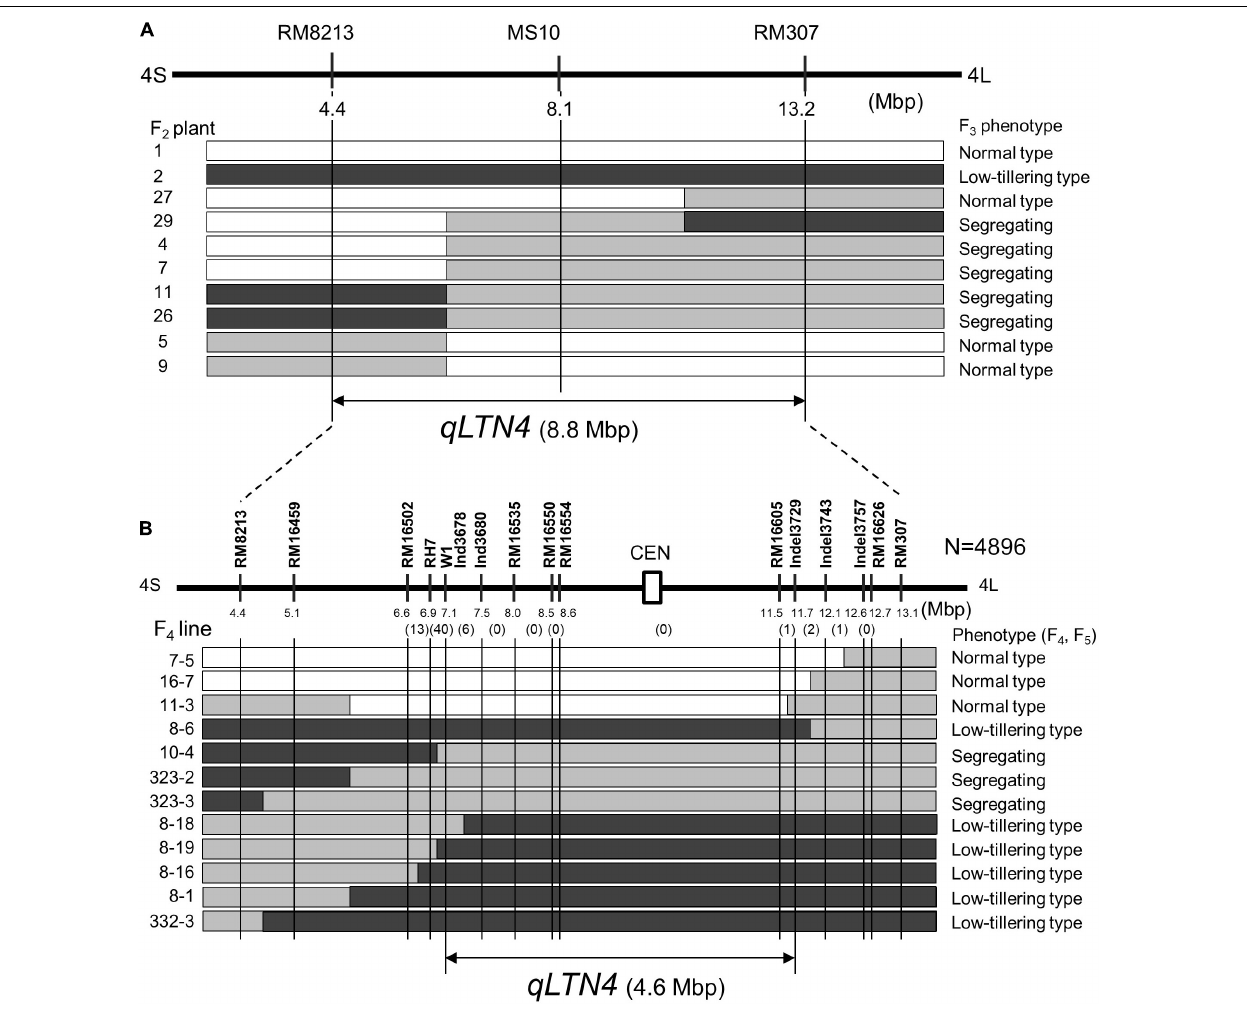
FIGURE 5 | Substitution map of locus for low tiller number. (A) Substitution mapping of qLTN4 in F 2 plants and F 3 lines derived from a cross between “Takanari” and the low-tillering line. (B) Substitution mapping of qLTN4 in F 4 and F 5 lines. Black, gray, and white indicate regions homozygous for marker allele from low-tillering line, heterozygous, and homozygous for marker allele from “Takanari.” The white rectangle with CEN indicate centromere region of chromosome 4.